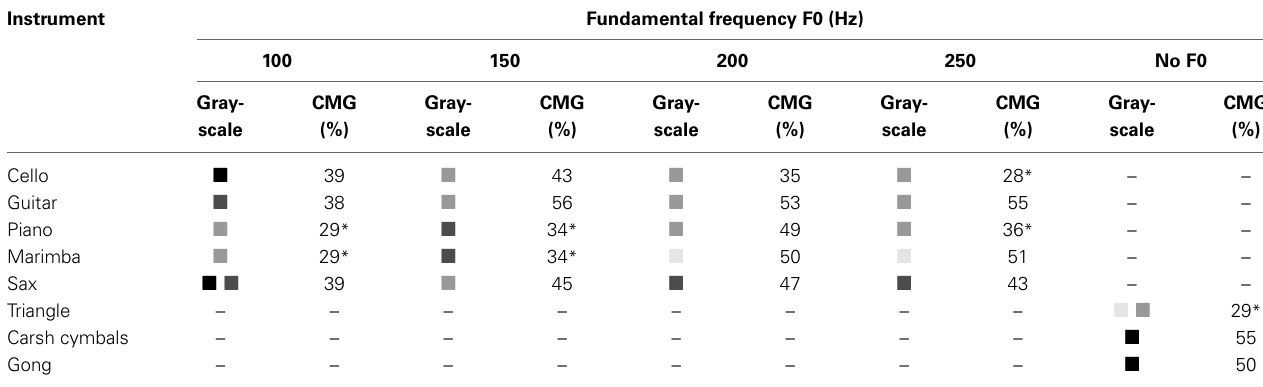
The grayscales are, from the lightest to the darkest, 0.9, 0.6, 0.3, and 0 (black). CMG is a confidence measure which shows what percentage of subjects have agreed on the selected grayscale. Sounds derived from Cello, Guitar, Marimba, and Piano have been mostly associated with light scales (0.6 and 0.9) and those of Sax, Crash Cymbals, and Gong have been mostly associated with dark scales (0 and 0.3). The chance level is 25%. The distribution of grayscales for sounds marked with asterisks were not different from chance level (see text for